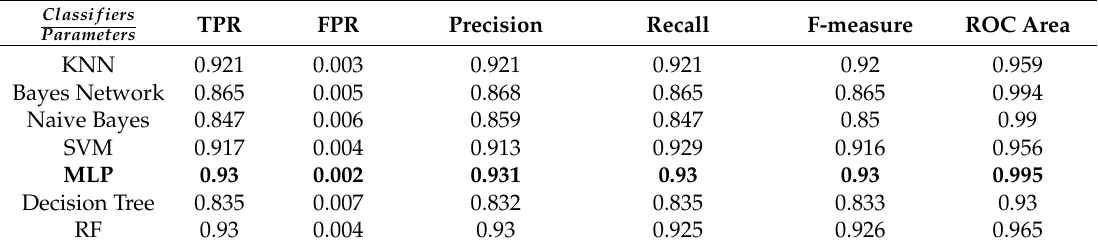
Figure 12. Classifiers accuracy performance comparison for OCR. Table 3. Comparison of performance metrics ( TPR , FPR , Precision , Recall , F - measure , and ROC Area ) of classification algorithms for